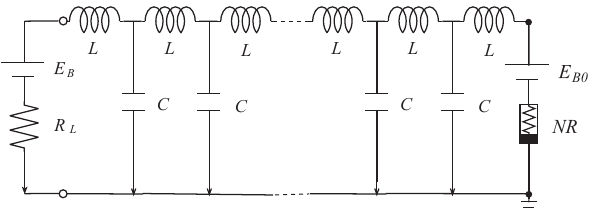
Figure 6. Transmission line circuit with standard side terminal